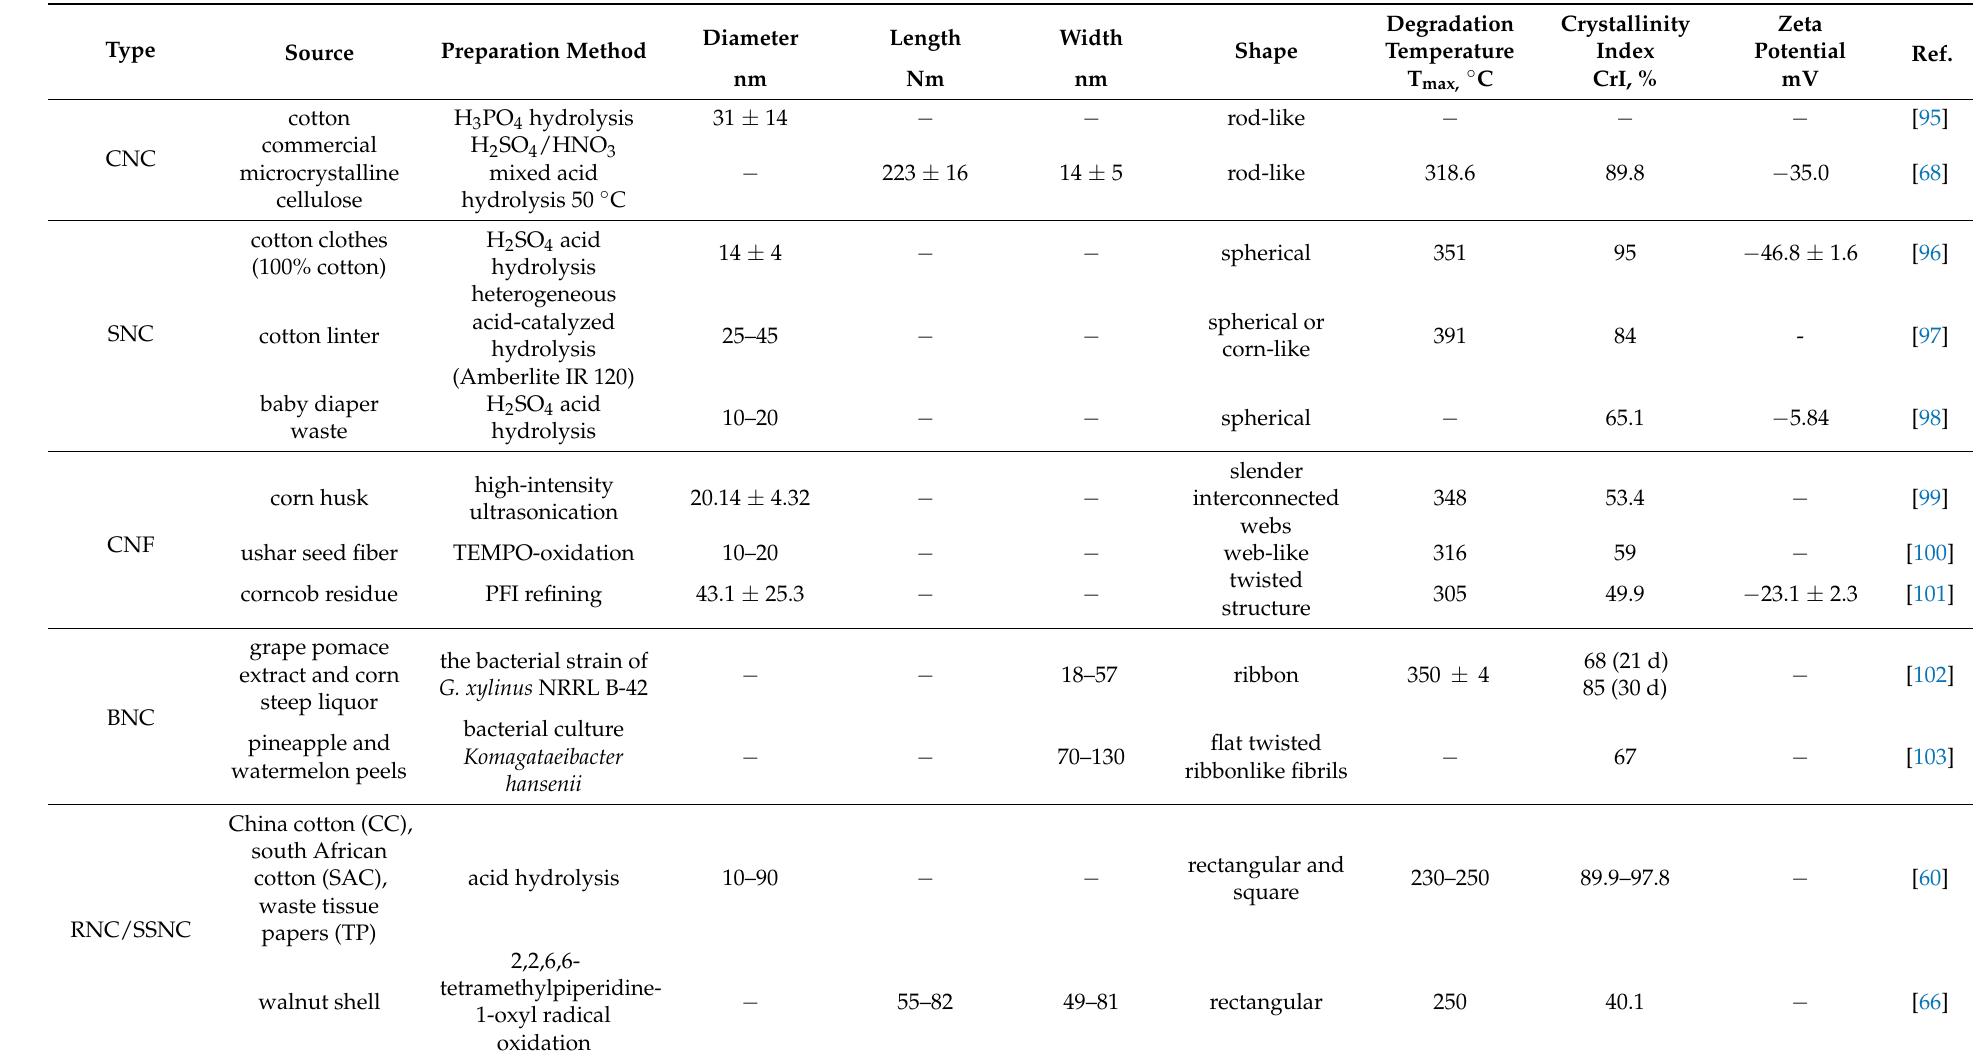
Table 3. Characterization of nanocelluloses in terms of their